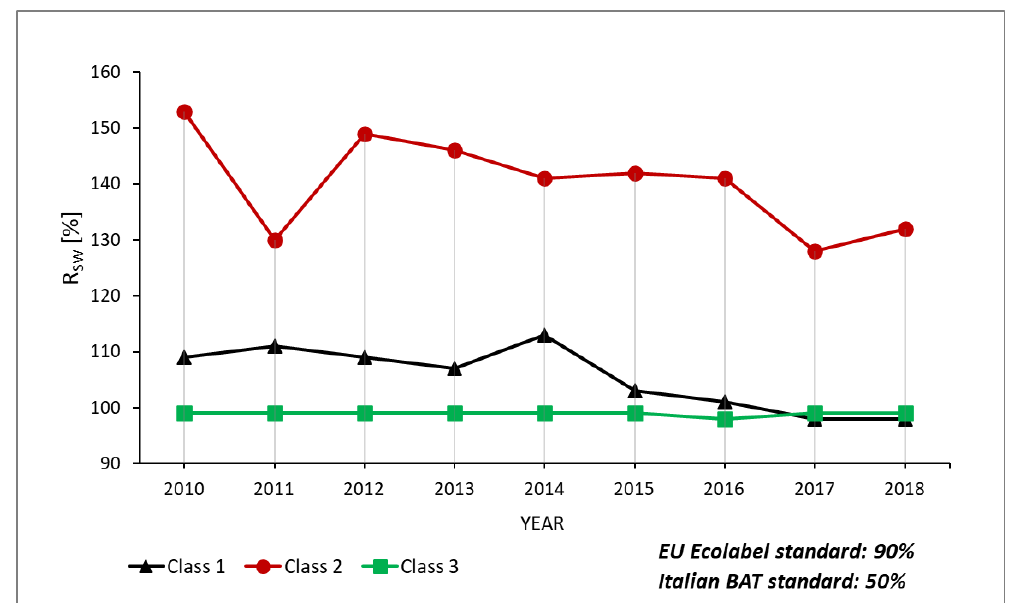
Figure 10. Trend for the recycling ratio of solid waste (R SW ). Data for all the three production classes are reported.